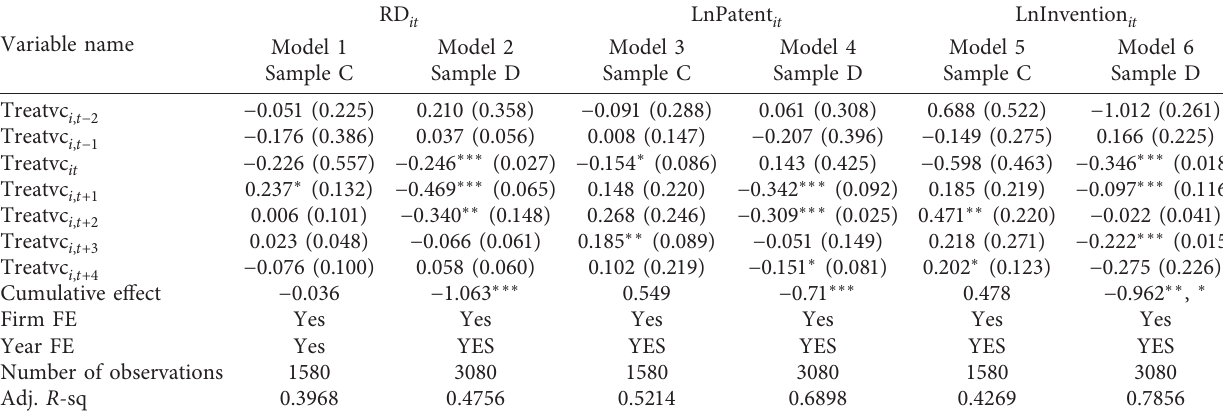
Table 4: Regression results: impact of VCs on the innovation level of firms whose actual controllers are experts in the same industry. Variable